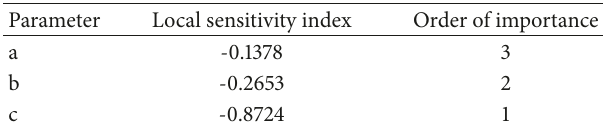
Table 3: Normalized sensitivity indexes and order of importance of 𝑧 ∗ to the three parameters evaluated at the values 𝑎 = 0.9 , 𝑏 = 0.2 , and 𝑐 =